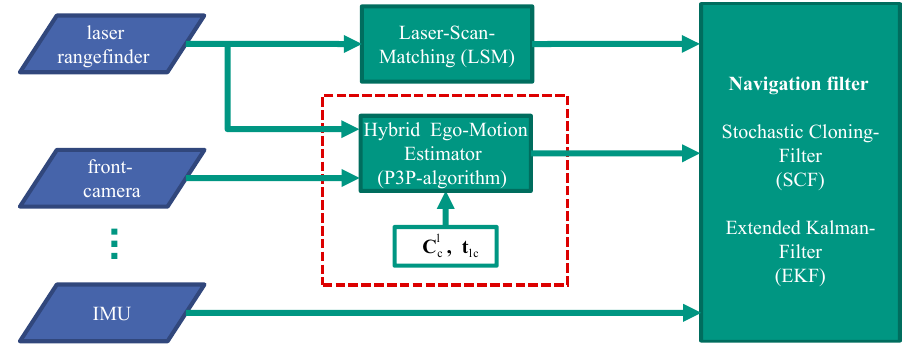
Figure 7. Different sensors and algorithms, including the hybrid ego-motion estimator, aid the navigation